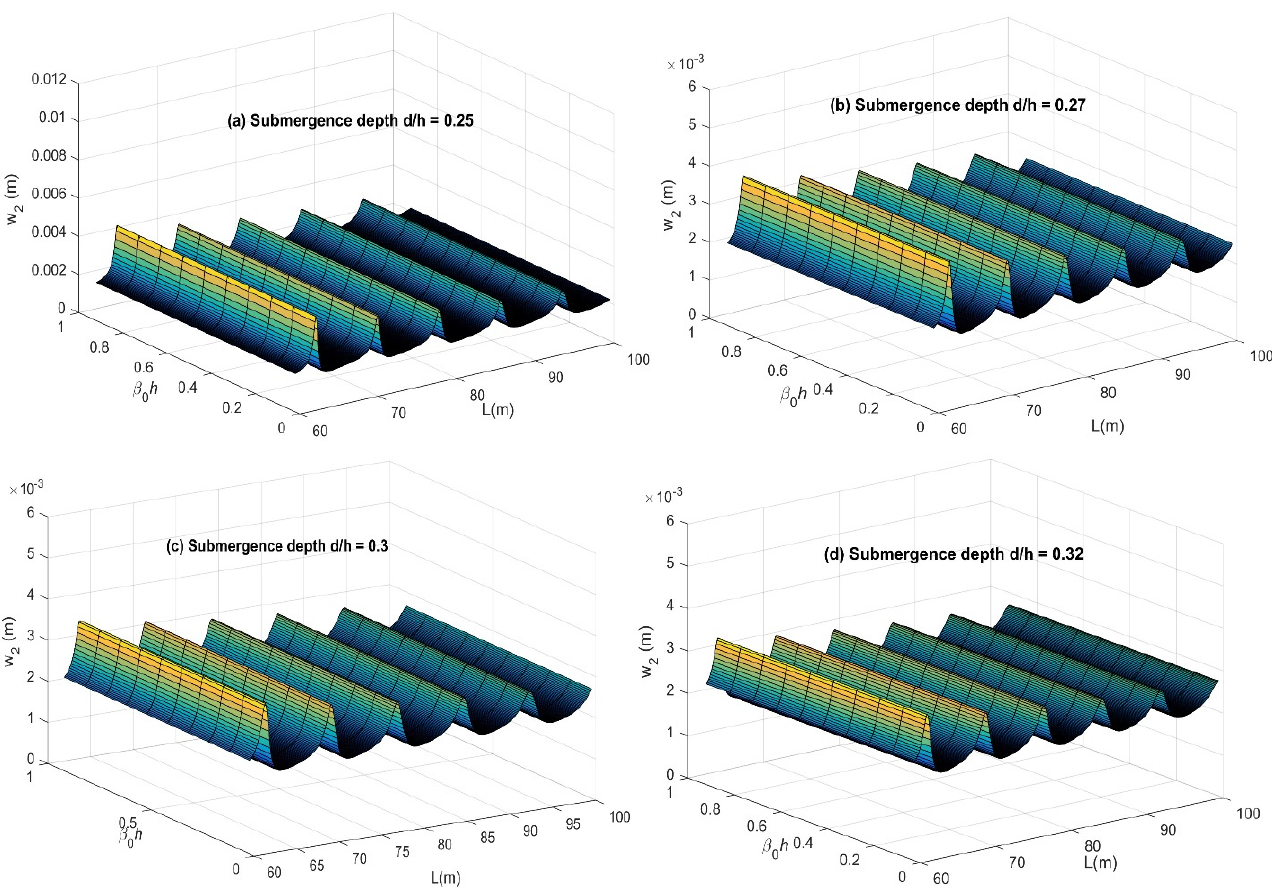
Figure 9. Submerged porous plate displacement with a floating flexible plate for various d / h with σ = 0.5 i and θ = 60 ( deg . ) . Figure 10 simulates the displacements, with 0.5 i σ= and 60 (deg.) θ = versus non-dimensional wavenumber, length, (m) L . In Figure 10a–d, for higher values of